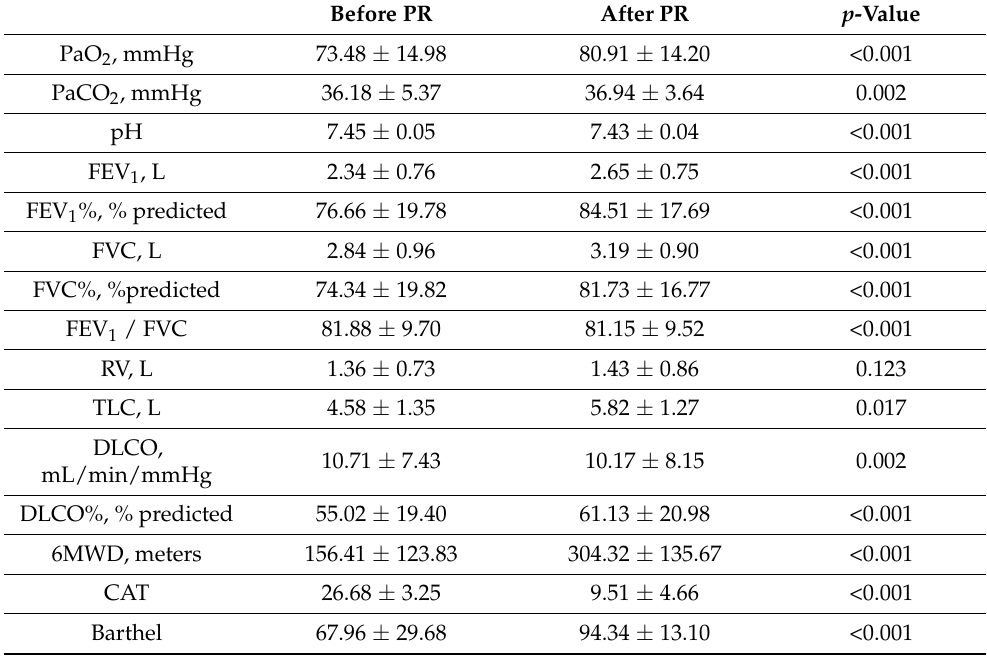
Table 2. Main clinical features and pulmonary function tests before and after pulmonary rehabilitation (PR) in 189 post-acute COVID-19